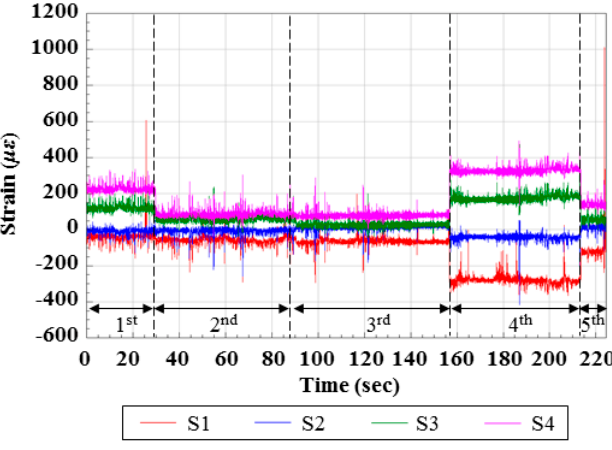
Figure 3. Strain gauge locations of disk harrow arm.